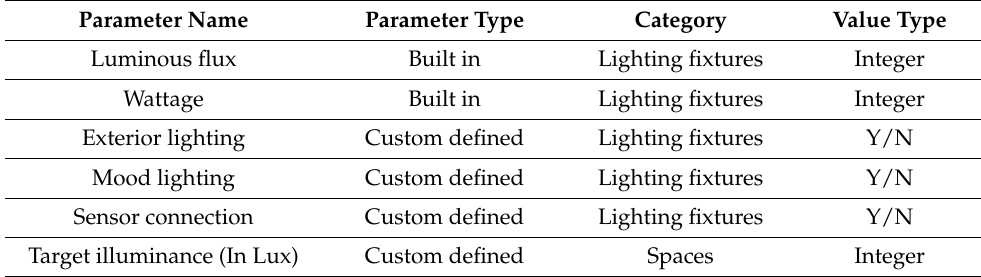
Table 6. Parameters used in REVIT ENE4